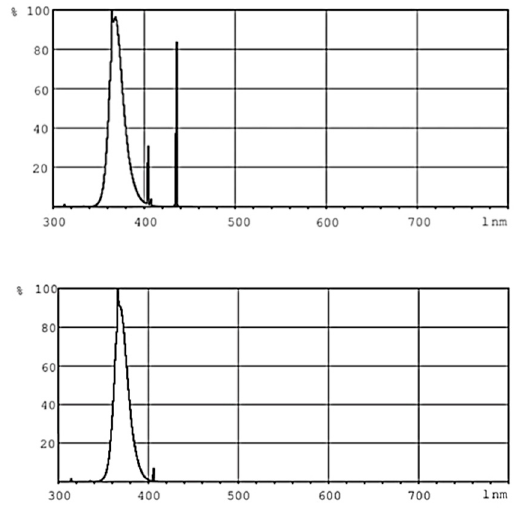
Figure 2. Light spectrum of the actinic lamp (upper image) and of the ultraviolet lamp (bottom image) used in this study [65,66].